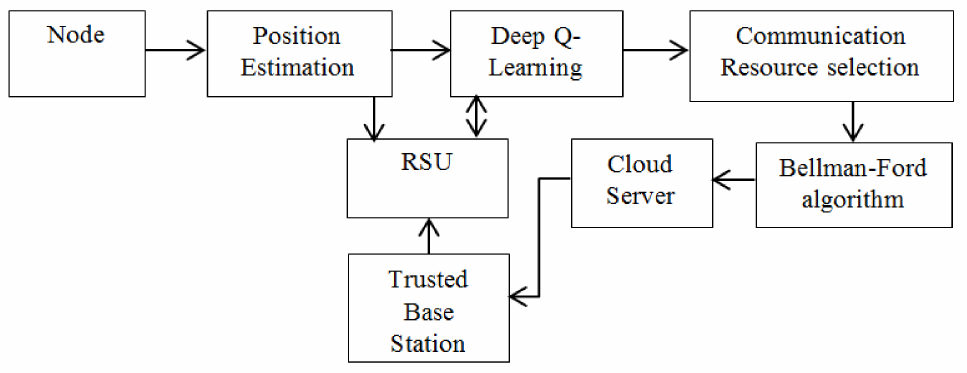
Figure 5. The DRL